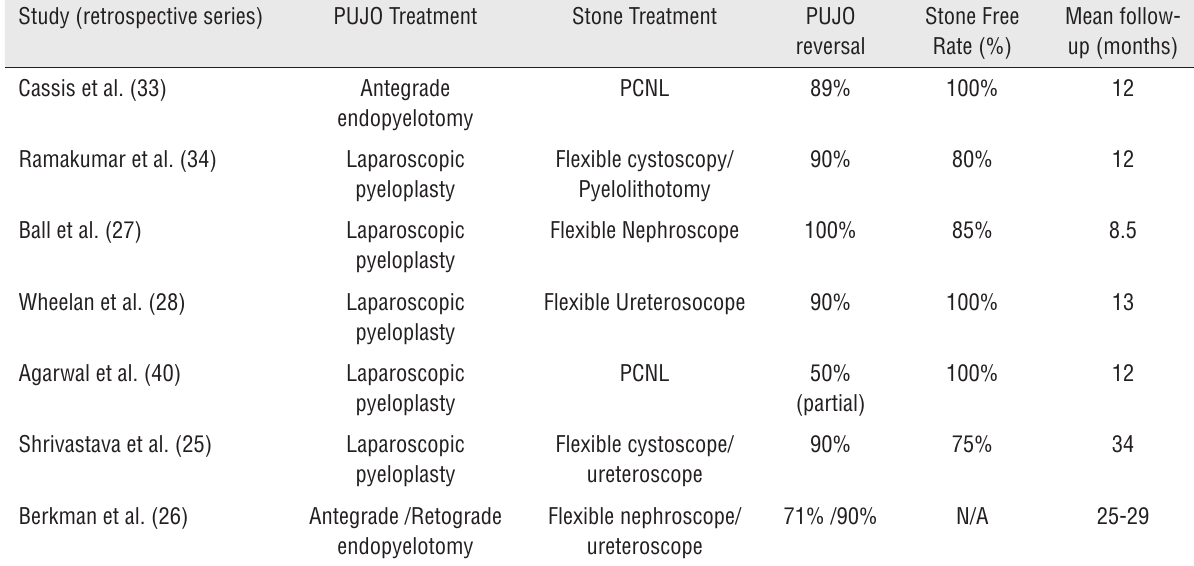
Table 2 - Summary of results following simultaneous PUJO correction and stone treatment. Study (retrospective